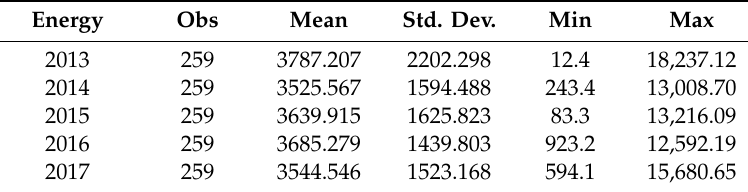
Table 3. Evolution of electricity consumption (kWh /